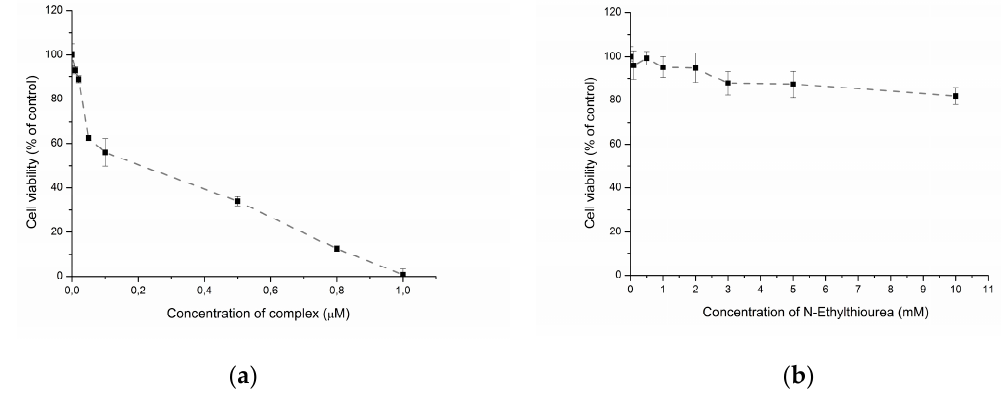
Figure 2. Cytotoxicity towards A172 cells of ETM ( a ) and N -ethylthiourea ( b ) after 72 h exposure.